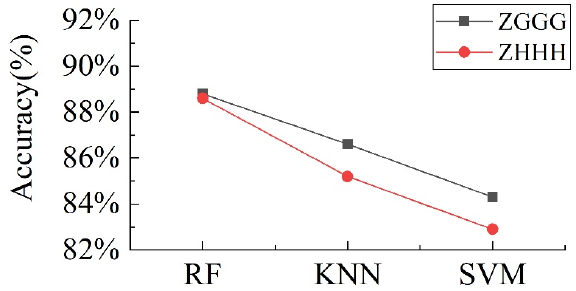
Figure 14. Comparison of the prediction accuracy of the three algorithms.In terms of feature selection, as shown in Table 2, nine features representing weather and flight plan information are selected. To reach the highest prediction accuracy, only one feature is added in each experiment based on the last experiment, and the change in prediction ac- curacy after adding this feature is shown to represent the influence of this feature on the prediction of arrival flight operation strategies. Figures 15 and 16 show the change in pre- diction accuracy while adding features using 10-fold cross-validation. Prediction accuracy increased with the addition of features, and prediction accuracy reached 88.8% for the ZGGG terminal and 88.6% for the ZHHH terminal while using 90%VIL, Coverage, Dura- tion, Plan route, Max VIL, and Plan AF as input features. The prediction performance is limited and even reduced by adding more features. Therefore, the first six features in Ta- ble 2 are selected for the establishment of AFOSPM . Table 2. Features and